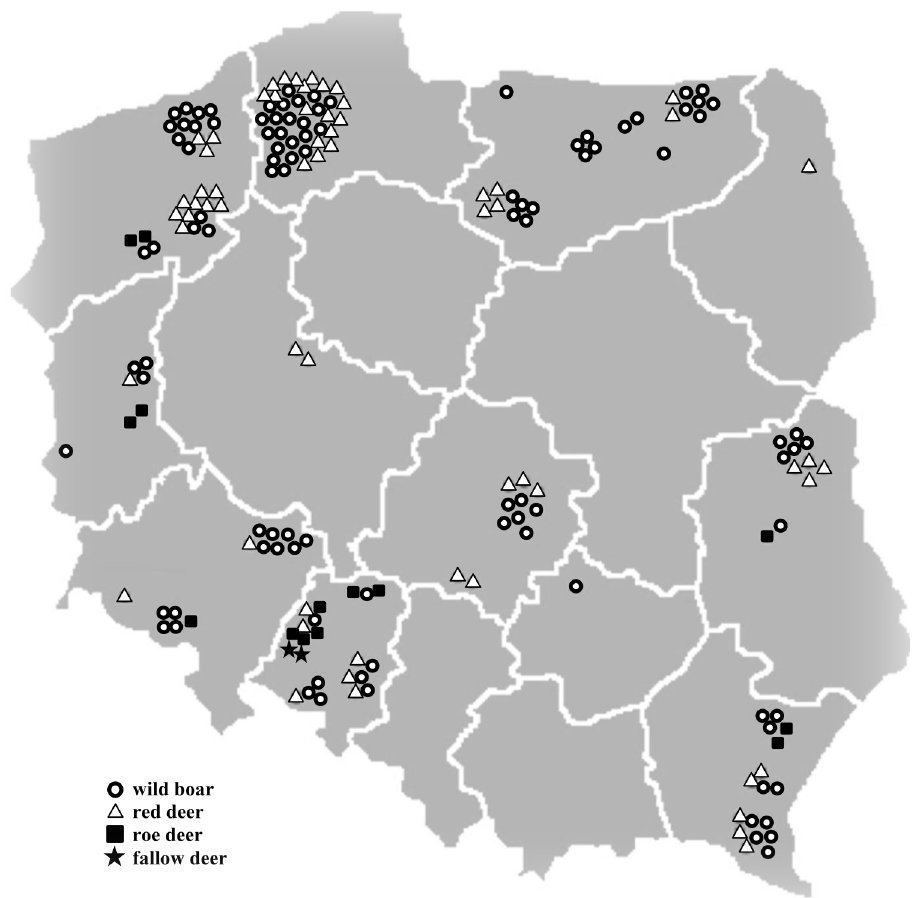
Fig 1. Geographical distribution of Yersinia enterocolitica positive samples in the Polish